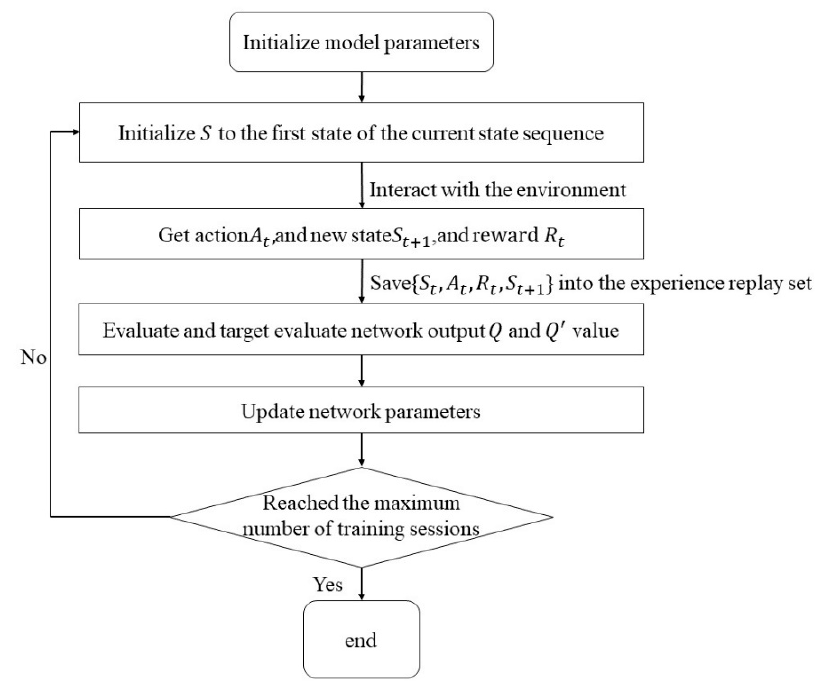
Figure 7. Multi-agent interactive learning flow chart.